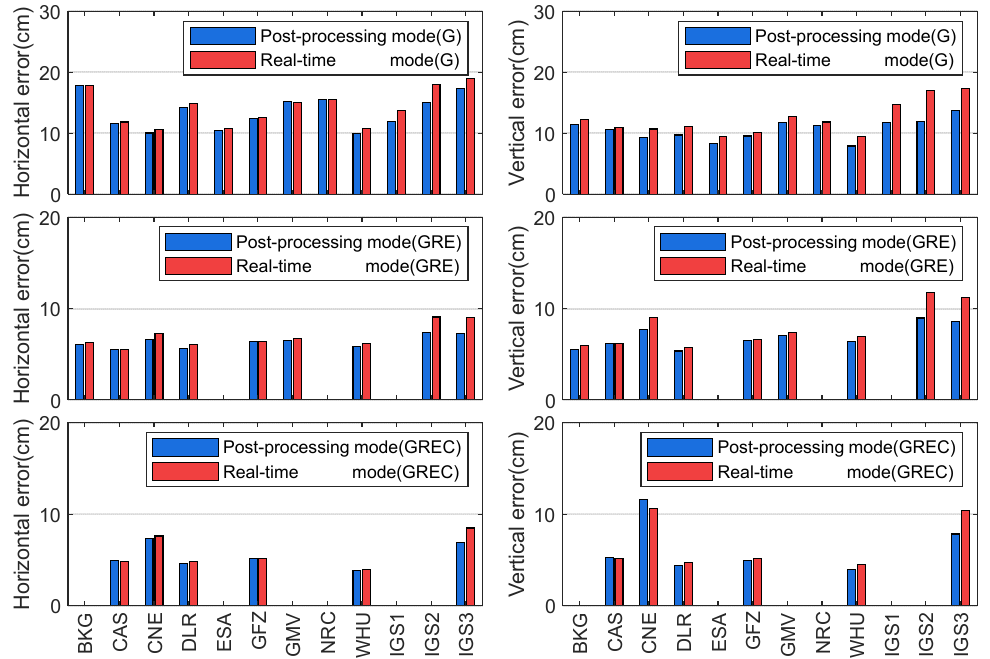
Figure 11. Simulated kinematic PPP errors using different SSR products for the 16 IGS stations (1h).